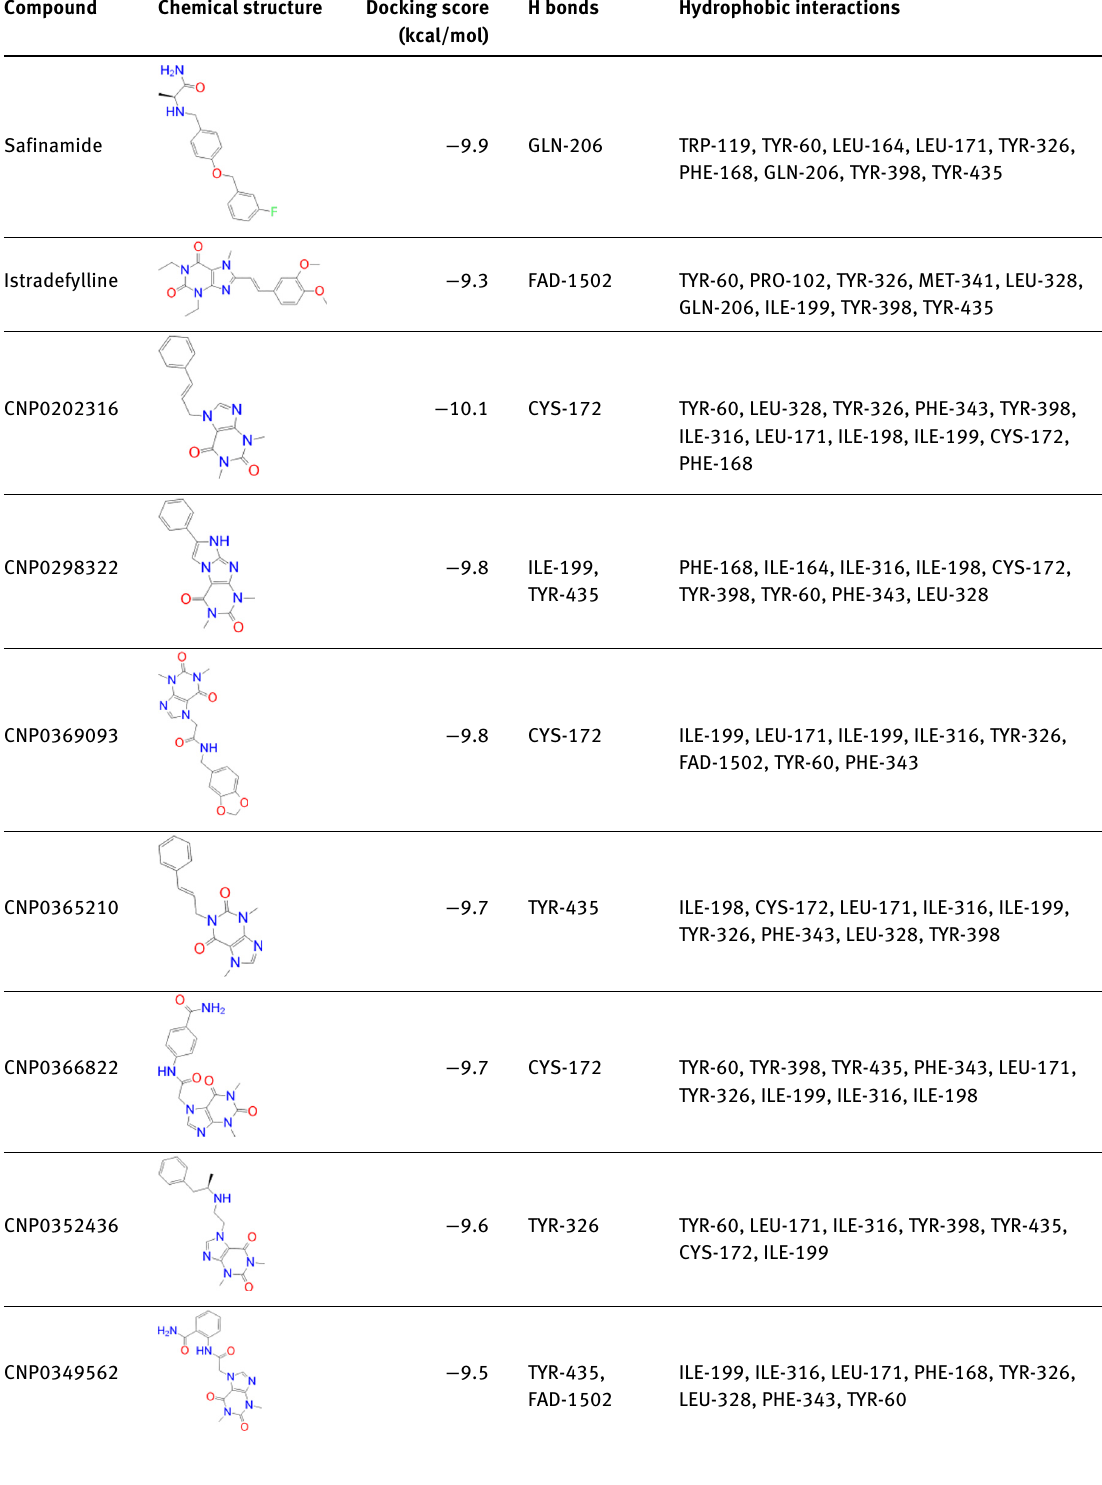
Table 1: Docking results and protein-ligand interactions between the highest-scoring compounds and